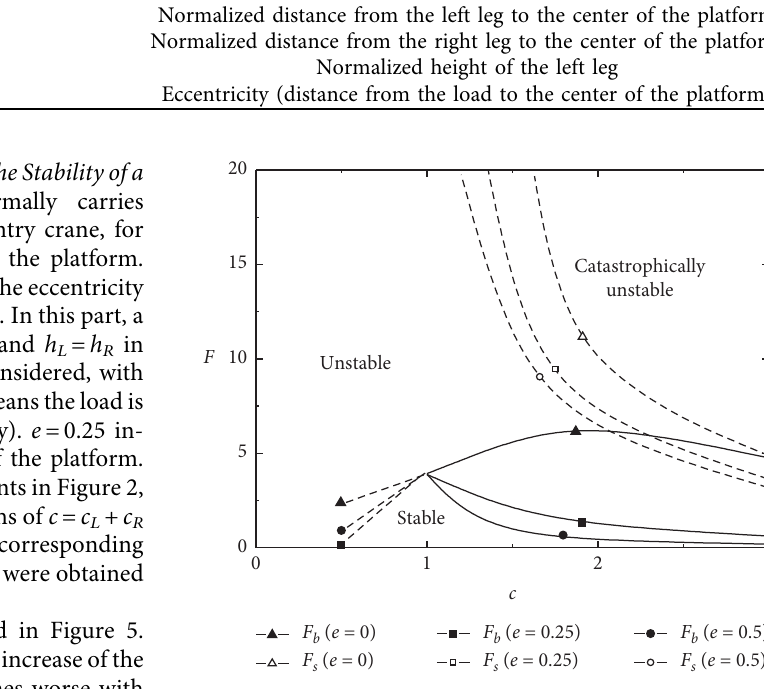
Figure 5: Effect of the eccentricity of loading e on the buckling load ( F b ) and snap through load ( F s ) of a symmetric portal